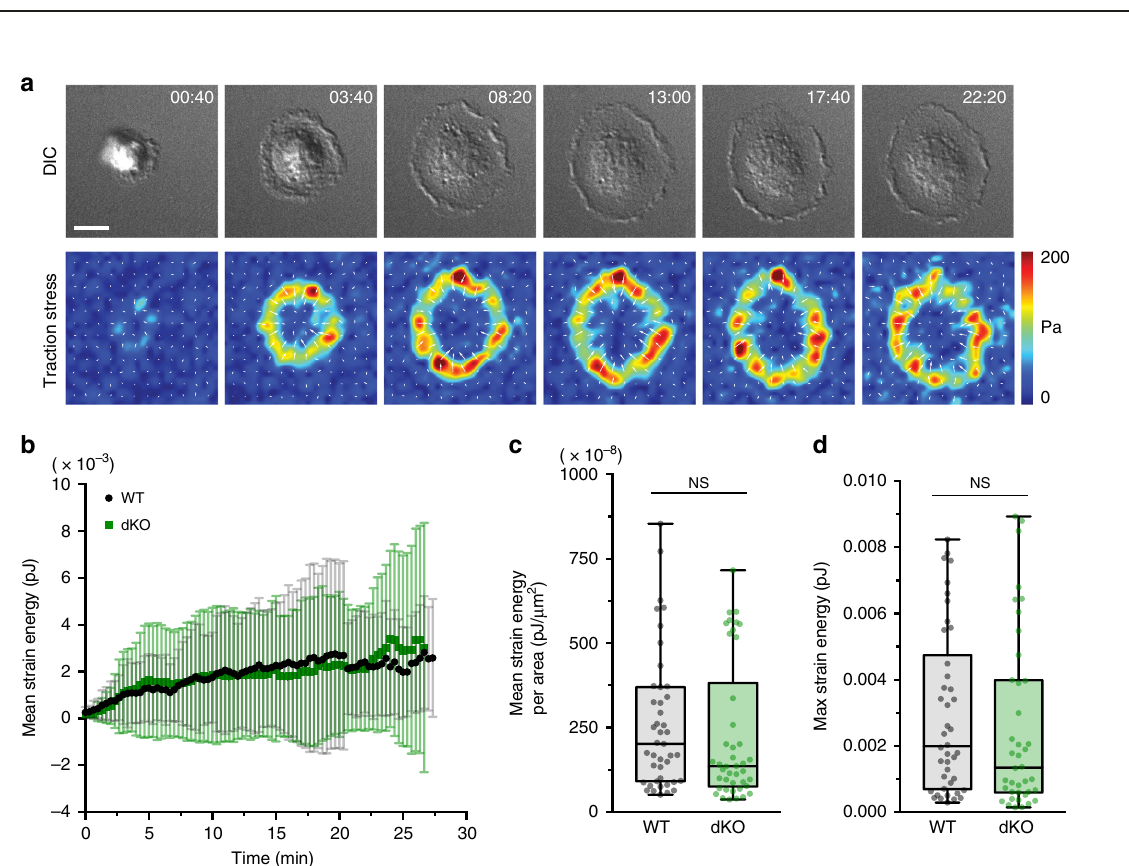
Fig. 1 Myo1e/f are required for ef fi cient phagocytosis. a Confocal section of EGFP-myo1e-transfected RAW264.7 macrophage engul fi ng 6 μ m IgG-coated bead and stained with fl uorescent phalloidin. Yellow arrowhead indicates the phagocytic cup, dotted line outlines the bead. Scale bar, 5 μ m. b Line scan of EGFP-myo1e and F-actin intensity along the line in a . c Maximum intensity projection of a shows that myo1e precedes actin at the cup leading edge. Scale bar, 5 μ m. d Time-lapse montage of RAW macrophage expressing mScarlet-myo1e and Lifeact-EGFP engul fi ng 8 µ m IgG-coated bead. Yellow arrowhead points to myo1e preceding F-actin, particularly at cup closure. Scale bar, 5 μ m. e Myo1e and myo1f colocalize at the edge of phagocytic cup. Confocal section of tdTomato-myo1e/EGFP-myo1f-transfected RAW macrophage engul fi ng 6 μ m IgG-coated bead (dotted line). Scale bar, 2 μ m. f WT BMDM staining with anti-myo1e and phalloidin shows that endogenous myo1e colocalizes with F-actin at the phagocytic cup (arrow) formed around 6 μ m IgG- coated bead. Cup is open, facing upward. Total intensity projection of a confocal z-stack. Scale bar, 2 μ m. g Western blots of myo1e/f in RAW264.7 cells and WT, myo1e − / − , myo1f − / − , and dKO BMDM. Equal protein loading veri fi ed by Coomassie Blue staining. h Percentage (mean ± SEM) of cells that internalized at least one 6 μ m IgG-coated bead at 15, 30, and 60 min. Data from three to four experiments. Analysis of 15 – 30 FOV resulted on average in 1200 cells per genotype quanti fi ed per experiment (15 min: p = 0.005; 30 min: p < 0.0001; 60 min: p = 0.006, unpaired t -tests). i Images of phagocytosis assay at 15 min. BMDM are stained with phalloidin (green) and un-internalized beads (arrows) are stained red. White circles denote internalized beads (not visible in the fl uorescence image). Scale bar, 50 μ m. j Percentage of cells (mean ± SD) that bound at least one bead during phagocytosis time course experiments described in h (15 min: p = 0.7625; 30 min: p = 0.09; 60 min: p = 0.029, unpaired t -tests). k Percentage of cells (mean ± SD) that formed